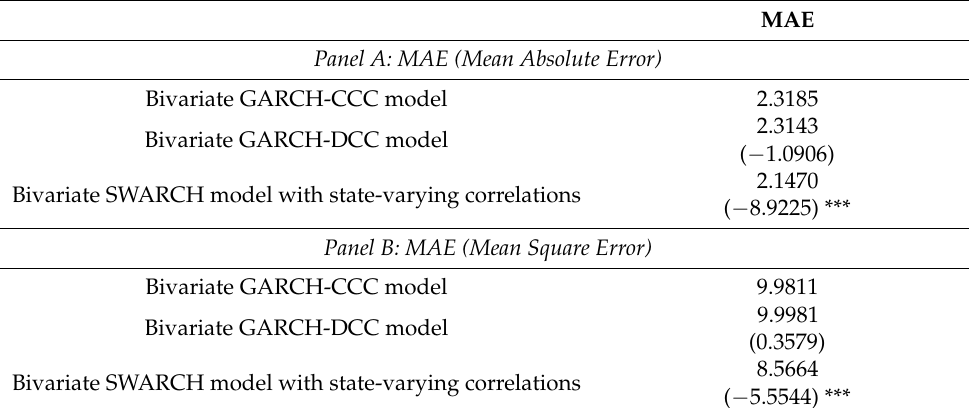
Table 7. Performance of EUA–WTI portfolio variance